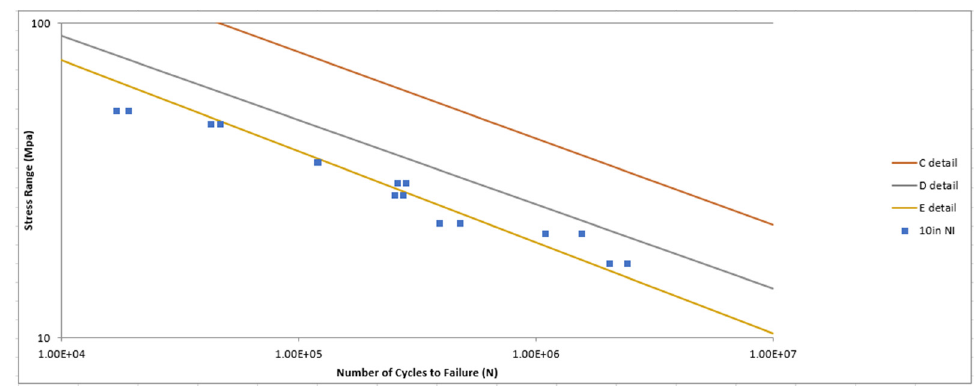
Figure 8. Fatigue test results.